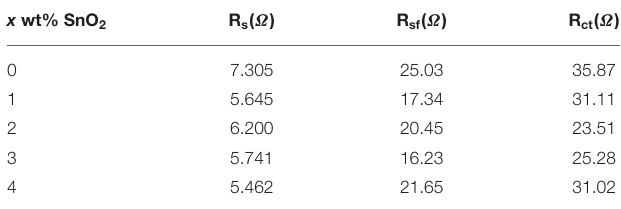
TABLE 2 | The fitting results of EIS after the 5th